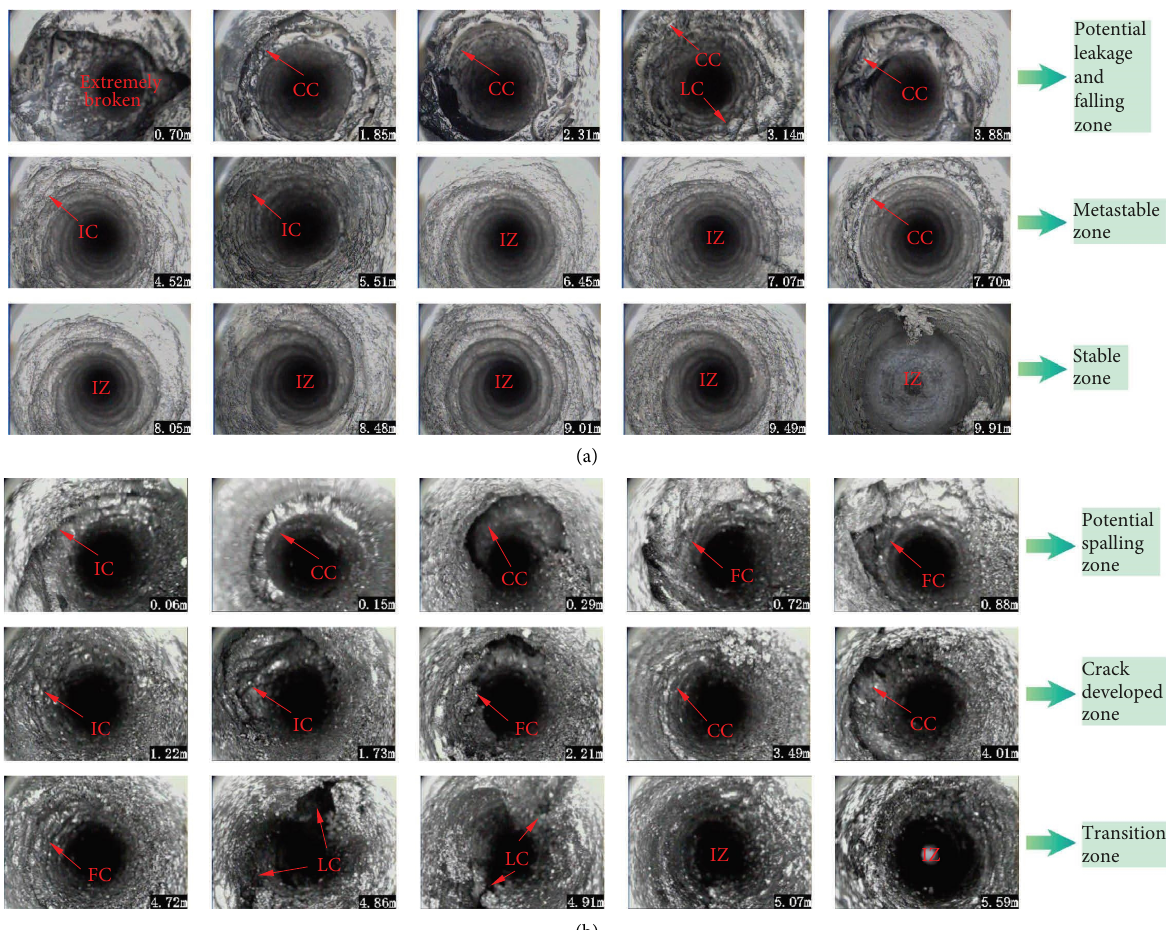
Figure 2: Internal structure of surrounding rock: (a) internal structure of roof; (b) internal structure of coal rib (CC means circumferential crack; LC means longitudinal crack; IC means interlaced crack; IZ means intact zone; FC means fracture zone).